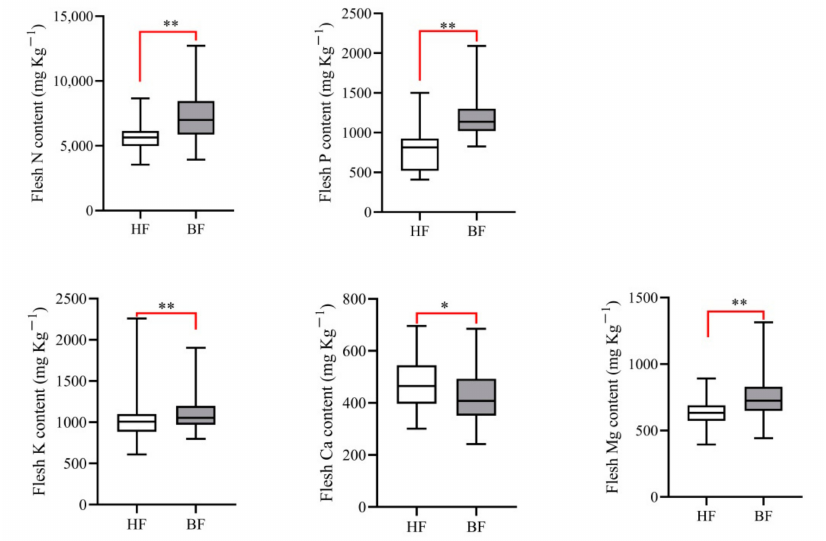
Figure 5. Box plots of N, P, K, Ca and Mg content in the healthy fruit flesh and internal flesh breakdown (IFB) fruit flesh. The highest and lowest quartiles are displayed above and below the box, and the line in each box represents the mean value. HF and BF represent the flesh of healthy fruit and fruit with IFB, respectively. Significant differences were determined by one-way ANOVA test: *, p < 0.05; **, p < 0.01; The same as below.